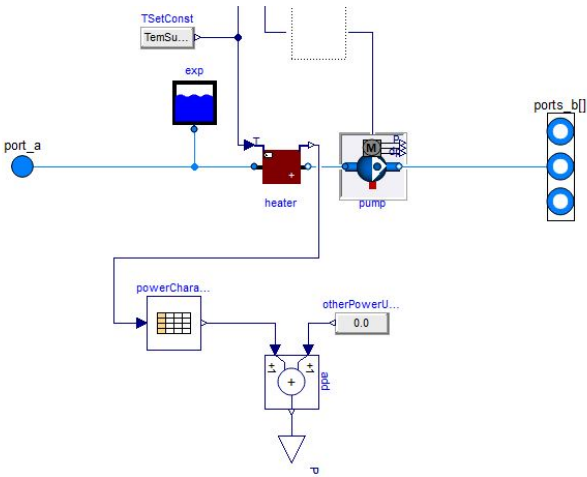
Figure 6. Diagram view of “Supply_pT” model component in Dymola.